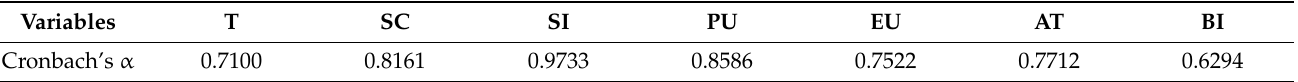
Table 8. Reliability and validity analysis on